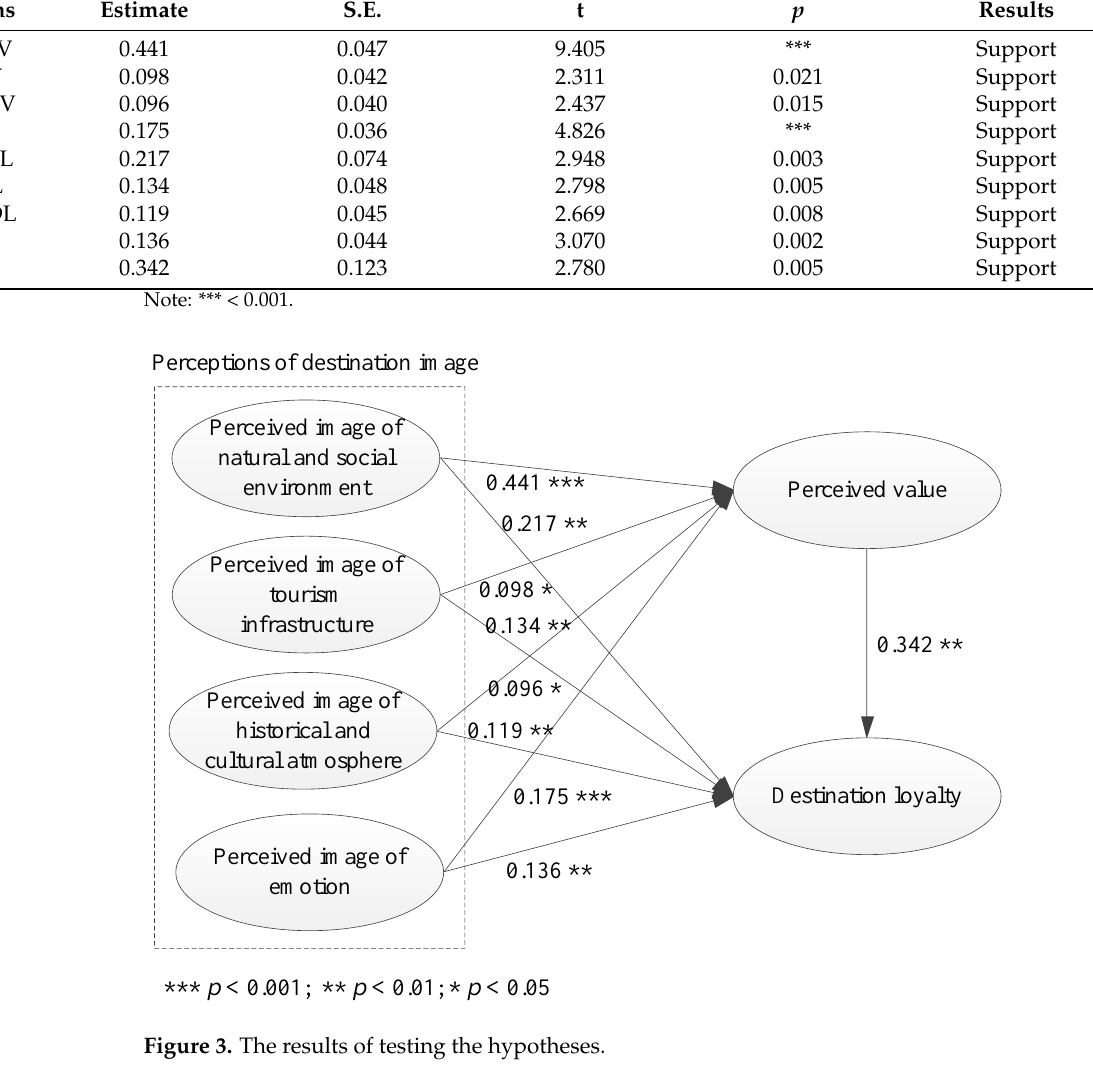
Figure 3. The results of testing the hypotheses.